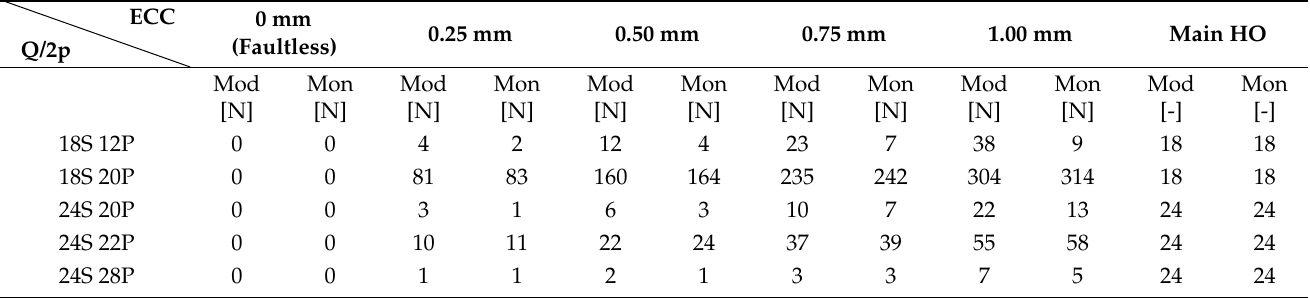
Table 6. Radial force ripple for different slot/pole combinations of PMSM and MPMSM in the presence of DE.